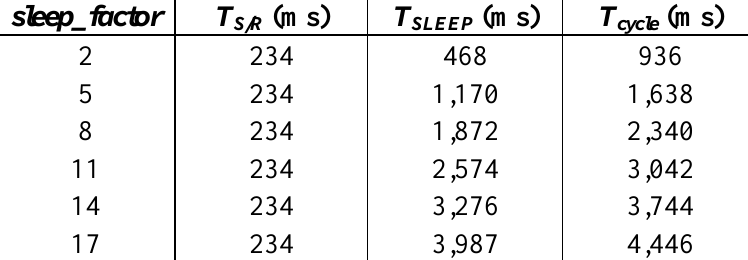
Table 4. Cycle duration with different sleep_factor